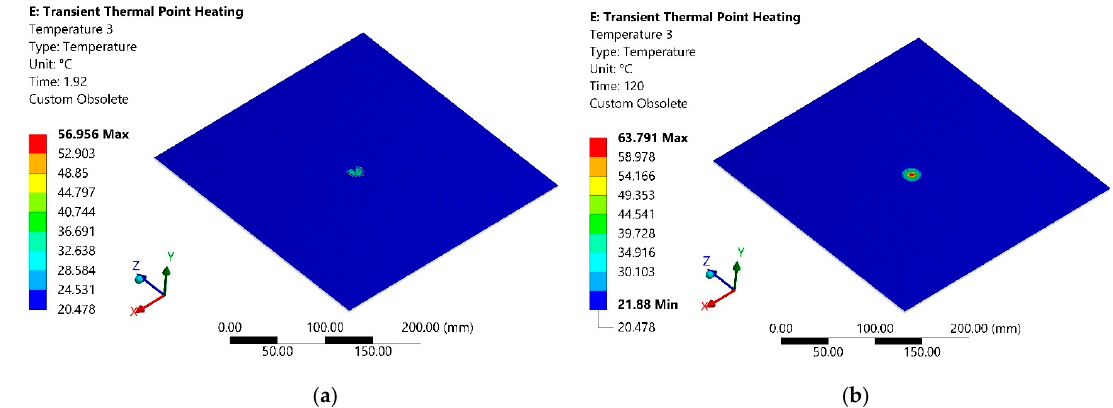
Figure 11. Temperature distribution on the opposite to the heating surface: ( a ) after 1.92 s from heating beginning; ( b ) after 120 s from the start of heating.